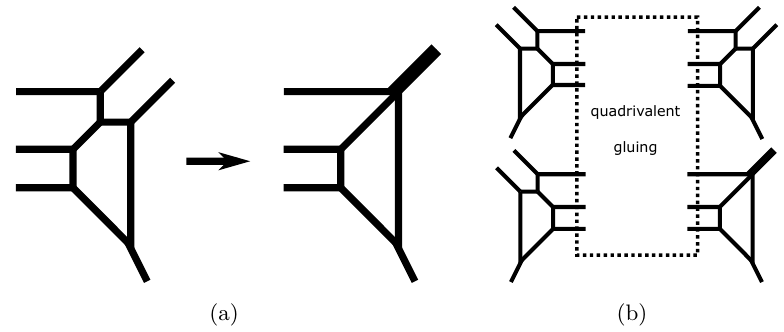
Figure 3. (a): The Higgsing which breaks an SU(2) for one of the four diagrams which are glued together in figure 2(b). (b): The web diagram of the theory which is realized after the Higgsing of the type (2 , 0 , 0 , 0)